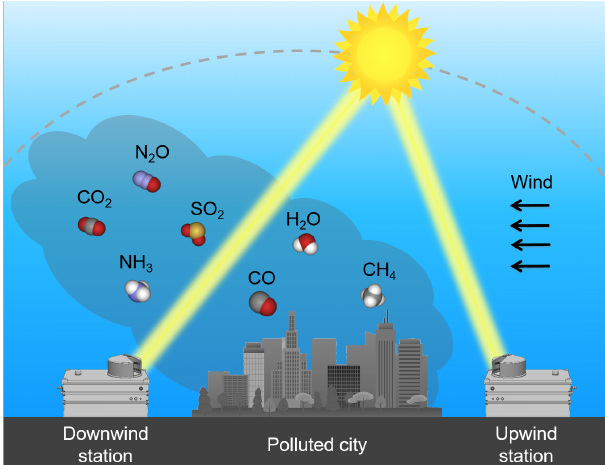
Figure 1. Basic principle of the differential column measurements: with the help of an upwind and at least one downwind station, the column-averaged GHG concentrations are measured. The differ- ences between the two stations are representative for the emissions generated in the